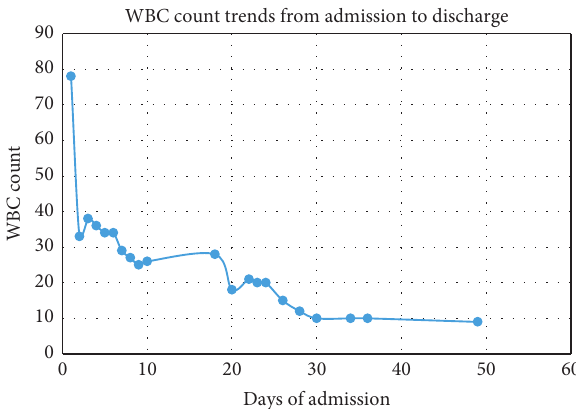
Figure 2: White blood cell trend postexchange blood transfusion.